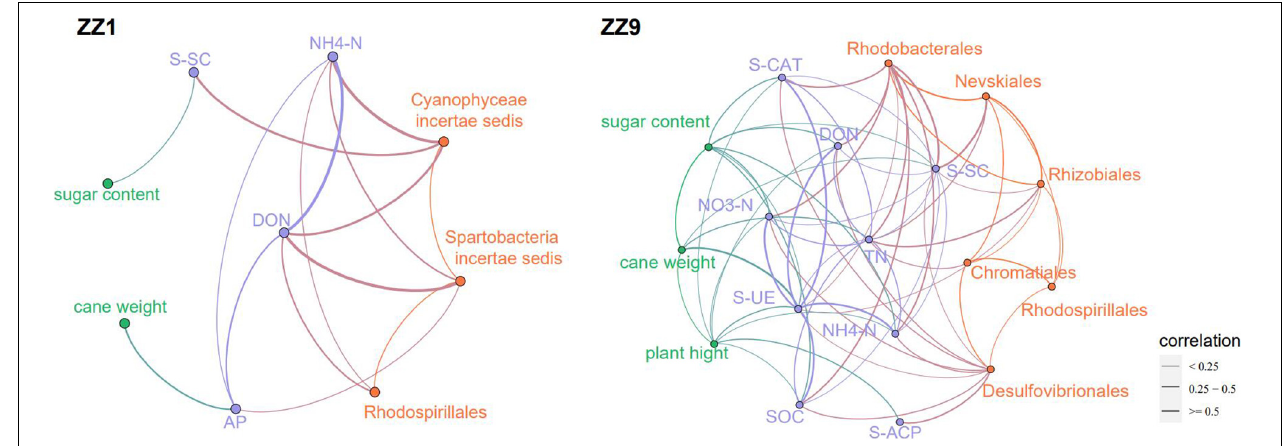
FIGURE 6 | The correlation network analysis of agronomic traits, environmental factors and bacterial genera between the two sugarcane cultivars, the thickness of the line reflects the